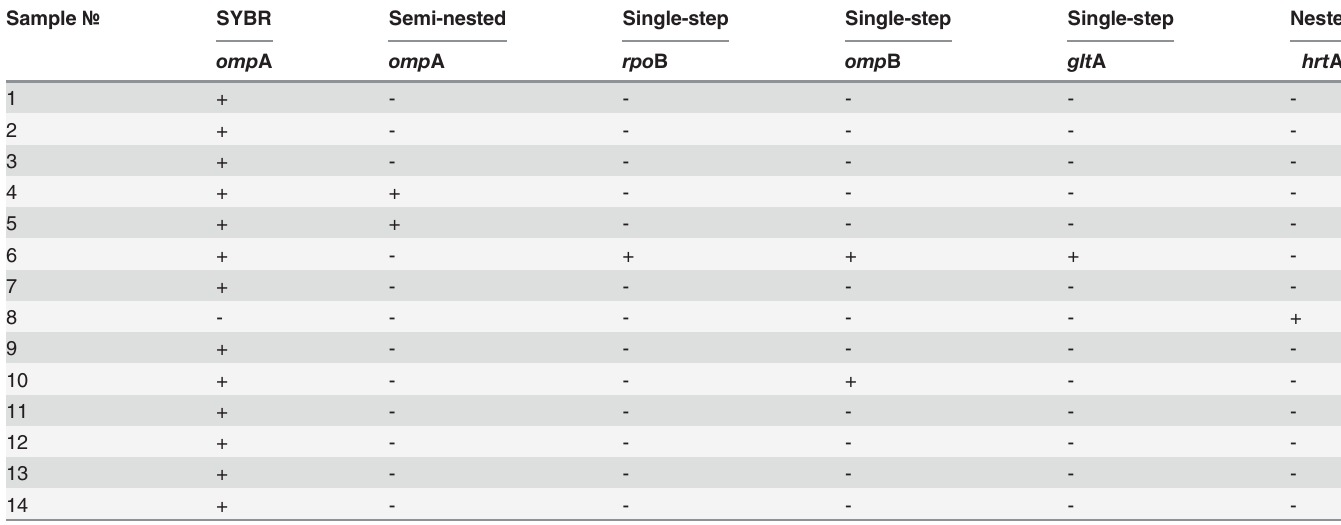
Table 3. Incongruence of PCR results performed by 5 conventional PCRs and real-time PCR on positive animal blood samples. Sample №